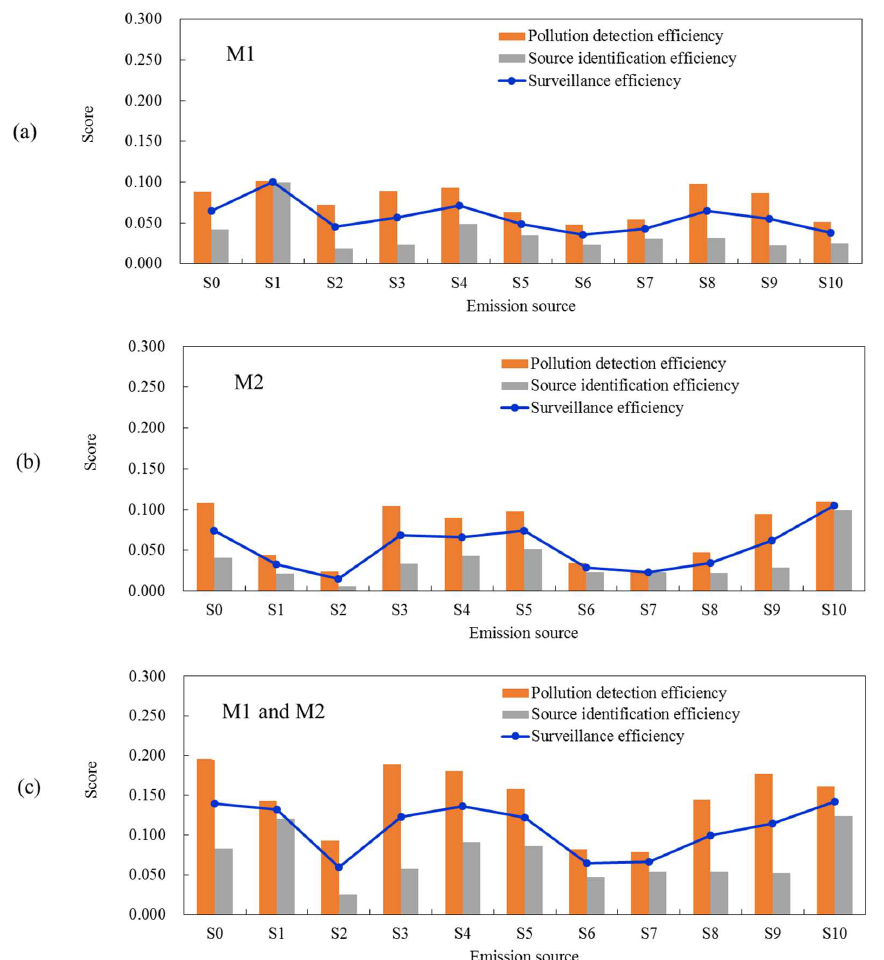
Figure 4. The individual and integrated performances of M 1 and M 2 for di ff erent real emission sources.